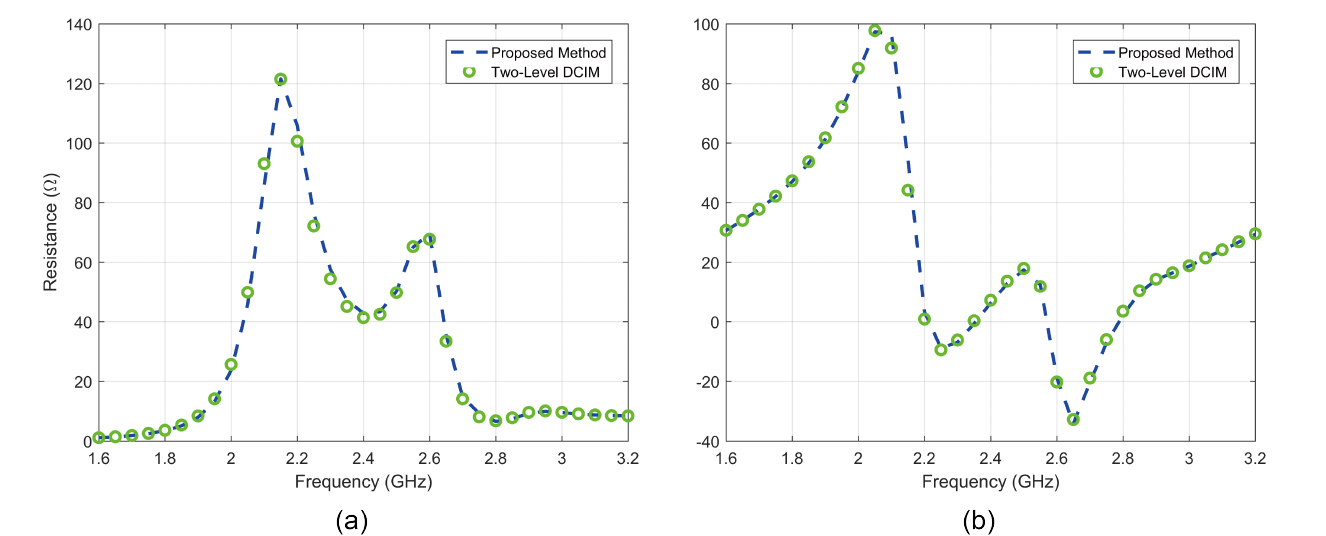
Figure 10. Input impedance of the stacked antenna simulated by different methods ( a ) resistance, ( b )